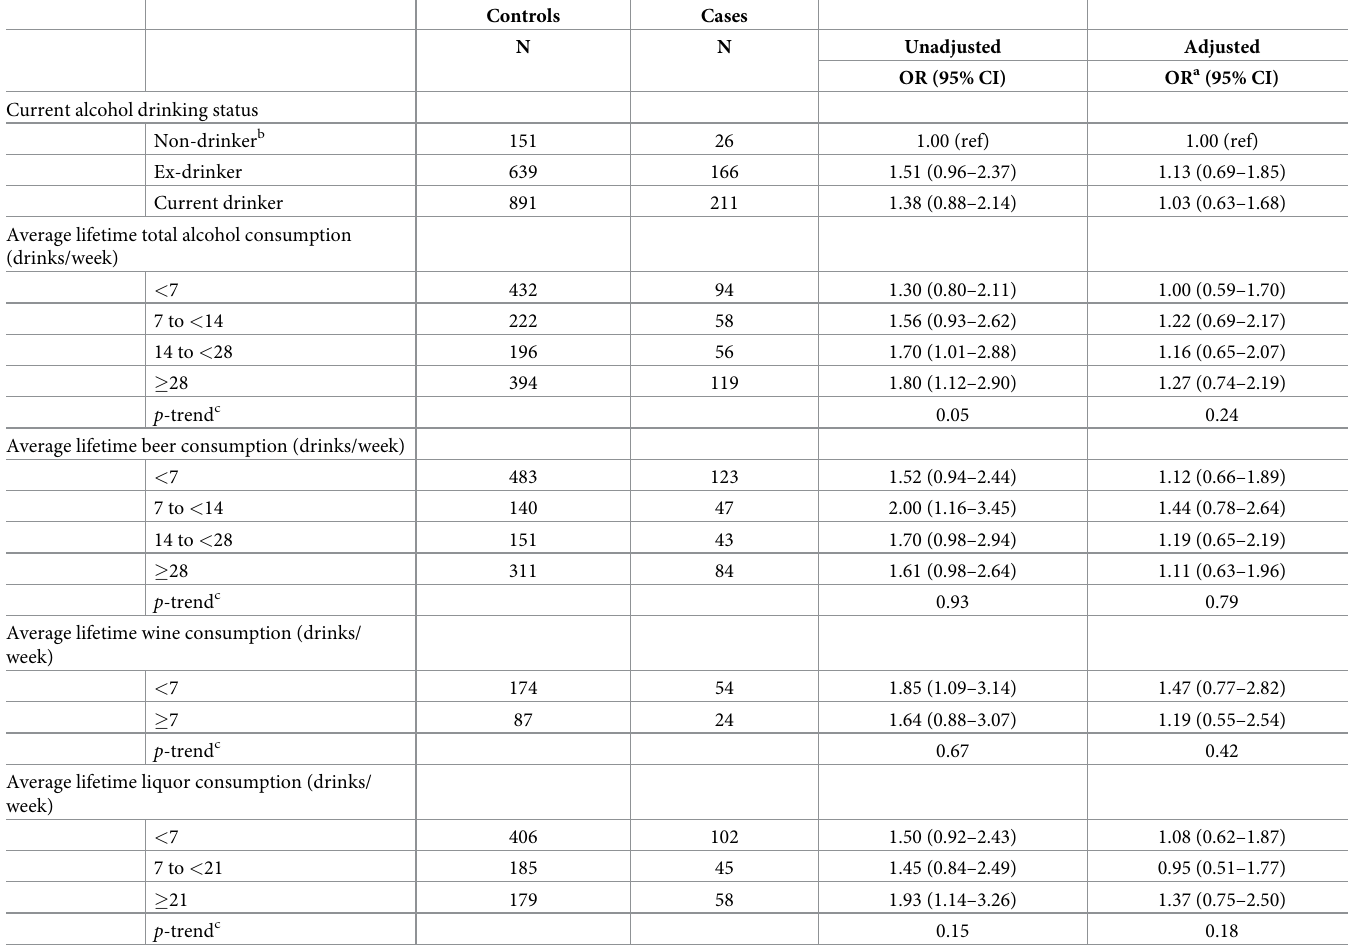
Table 2. Unadjusted and adjusted odds ratios for associations between alcohol-related variables and risk of gastric intestinal metaplasia.